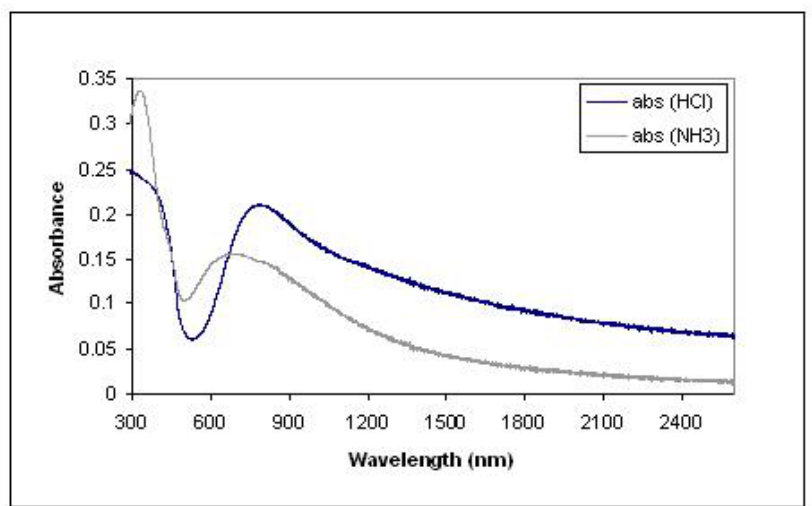
Figure 3. Polyaniline film response to Ammonia and HCl